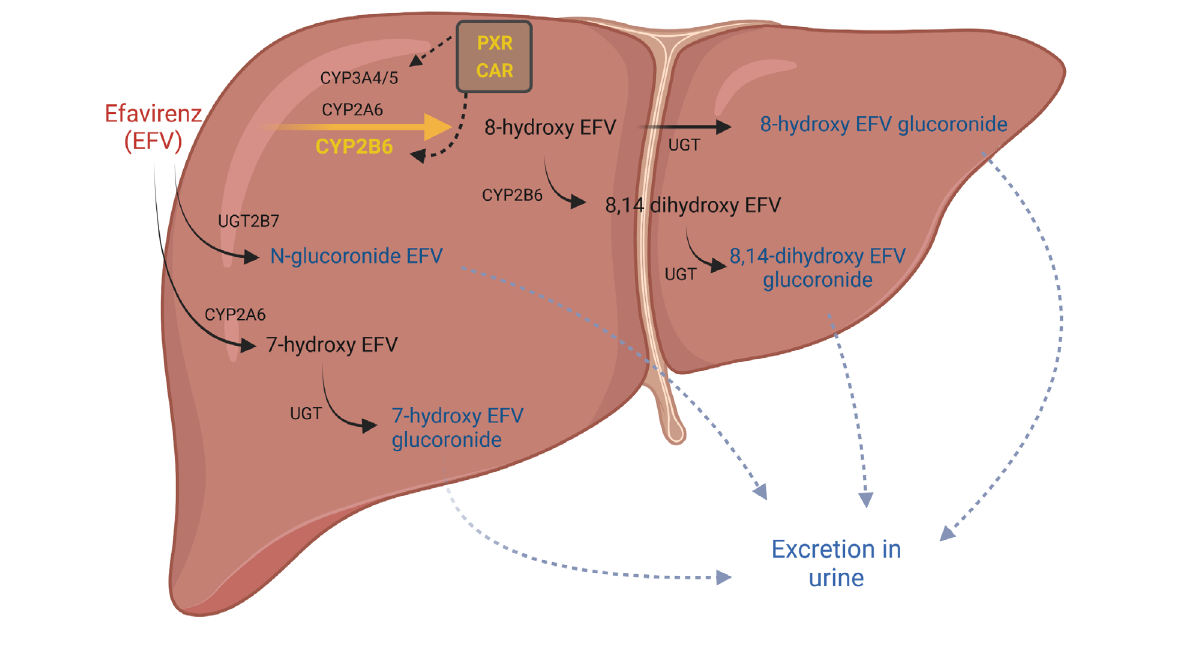
Figure 2. Efavirenz hepatic metabolism and pharmacogenetic associations in Latin American populations. CYP2B6 acts on primary efavirenz (EFV) metabolism pathway, converting EFV to 8-hydroxy EFV. Variations at CYP2B6 gene have been extensively associated with EFV plasma levels and also to adverse reactions to this antiretroviral. Other enzymes (CYP3A4, CYP3A5, CYP2A6) can also generate 8-hydroxy-EFV. Transcription factors PXR and CAR regulate expression of CYP2B6 and CYP3A enzymes, and may indirectly influence EFV metabolism. Polymorphisms at genes encoding PXR and CAR were associated to EFV exposure and virological response. Alternative pathways include hydroxilation by CYP2A6 and direct glucoronidation by UGT2B7. Intermediate metabolites are then glucoronidated before excretion in urine. Genes associated with EFV pharmacokinetics and/or response to EFV in Latin American populations are shown in yellow. Created with